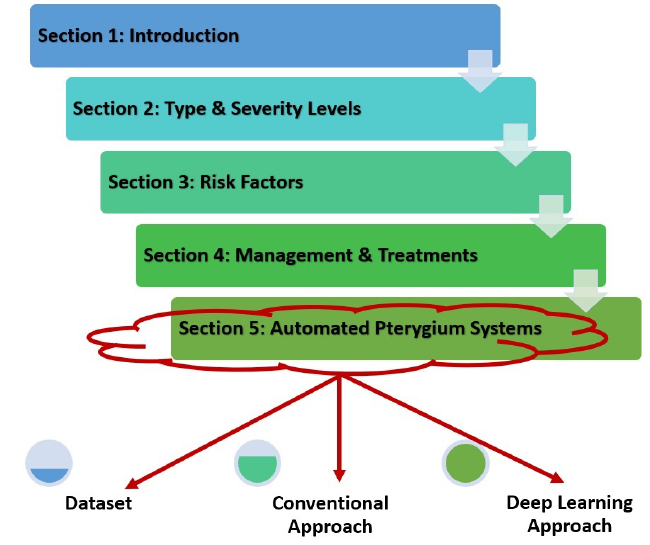
Figure 2. General information flow of this review